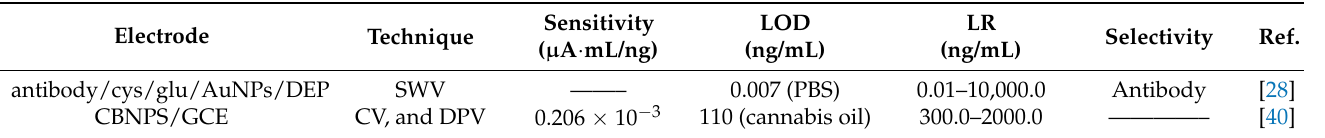
Table 3. A comparison of the sensing characteristics and functional materials of nanoparticle-modified electrochemical sensors for detecting ∆ 9 -THC and CBD.